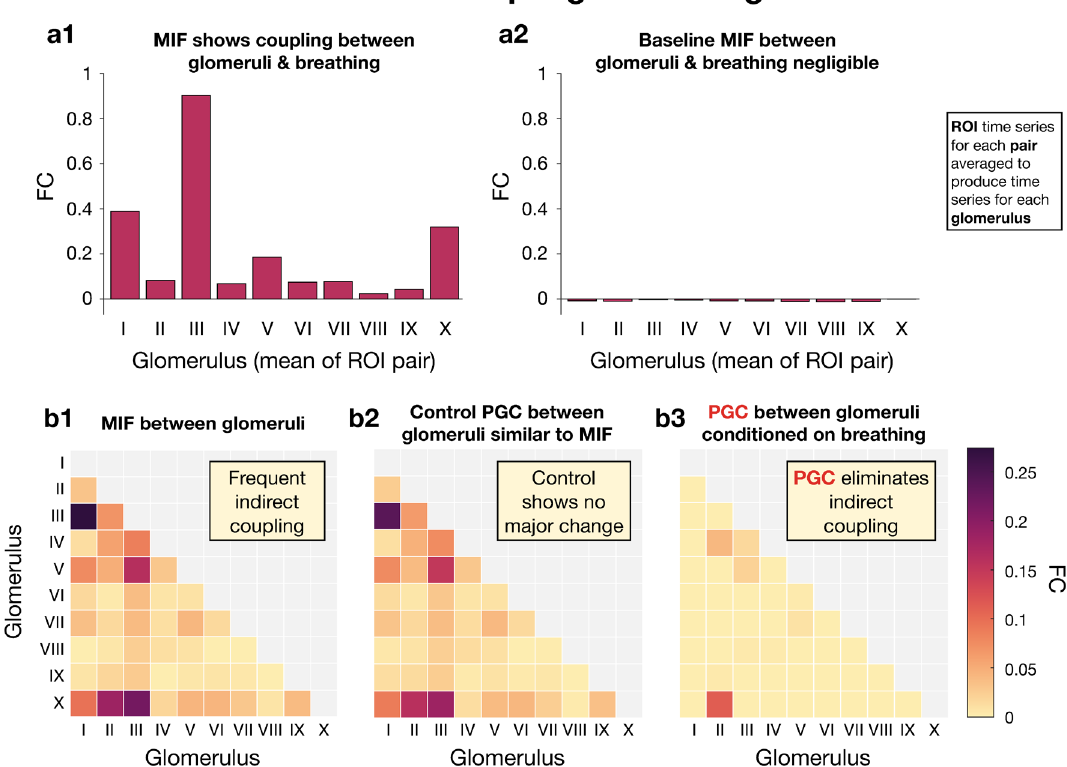
Figure 8. PGC analysis of glomeruli and breathing. ( a ): ( a1 ) MIF between glomeruli (average of each ROI pair) and breathing for relevant frequencies 2 and 3 Hz. ( a2 ) MIF between glomeruli (2 and 3 Hz) and breathing (49 and 50 Hz) to provide a baseline. Baseline MIF values were negligible because 49 and 50 Hz are uninformative frequencies of breathing. ( b ) FC between glomeruli. Diagonal and upper right grayed out because FC is symmetric. ( b1 ) MIF between glomeruli for 2 and 3 Hz. ( b2 ) PGC between glomeruli for 2 and 3 Hz conditioned on irrelevant breathing frequencies (49 and 50 Hz), referred to as control PGC. ( b3 ) PGC